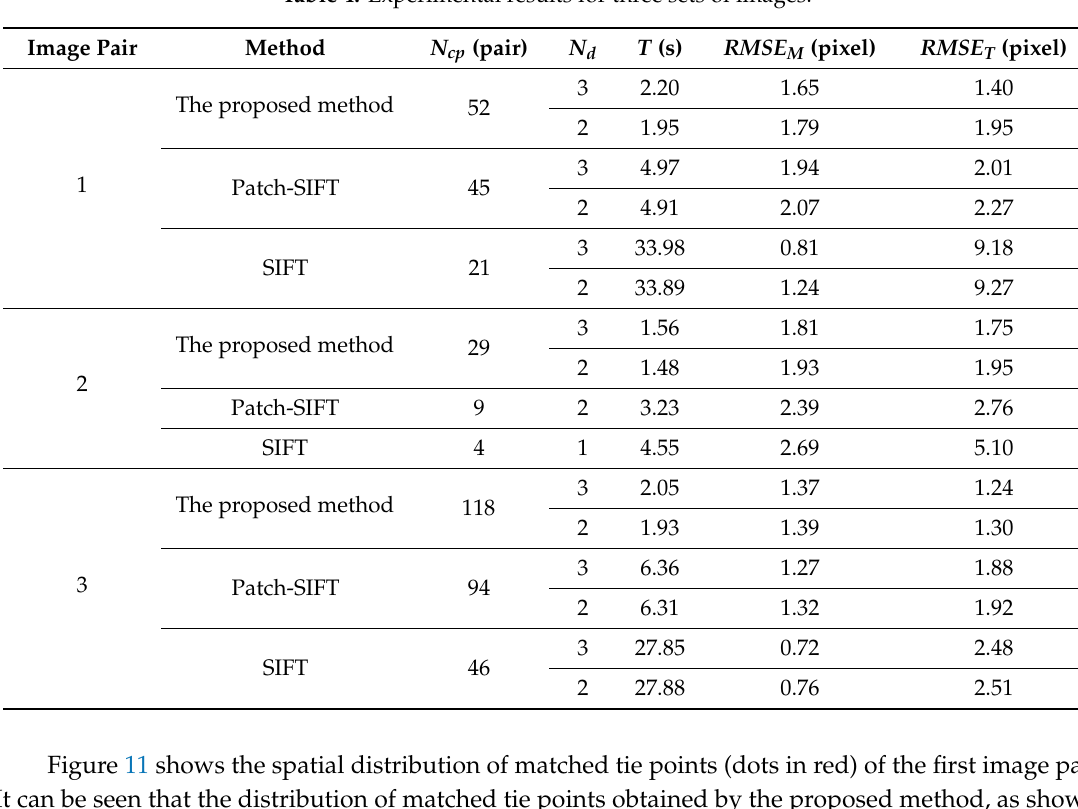
Table 4. Experimental results for three sets of images.